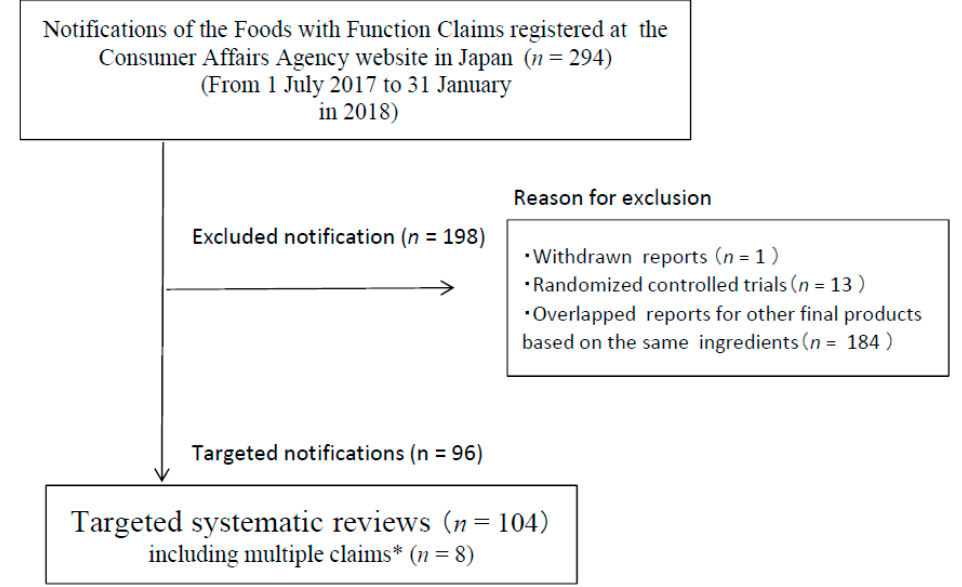
Figure 2. Flowchart of trial process. * A product has more than one functionality (e.g., decreased body fat and increased HDL cholesterol) and is displaying them.